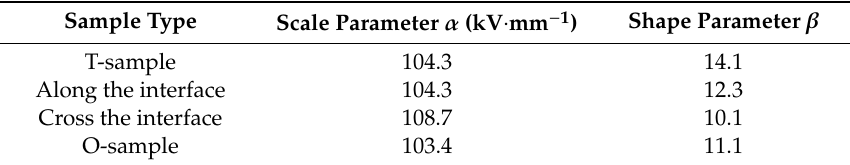
Table 4. Weibull distribution parameters of arc ablation resistance of different samples.